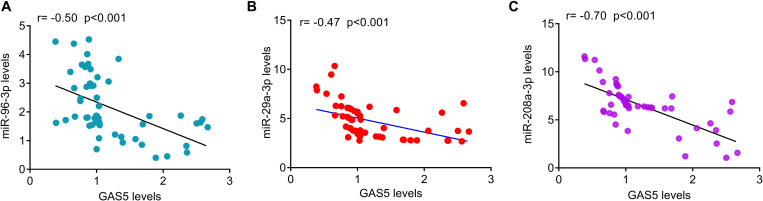
The correlation of serum GAS5 levels with serum miRNAs levels in patients with T2DM. (A) Serum GAS5 levels were negatively correlated with miR-96-3p levels in patients with type-2 diabetes (r = –0.50, p < 0.001). (B) Serum GAS5 levels were negatively correlated with miR-29a-3p levels in patients with type-2 diabetes (r = –0.47, p < 0.001). (C) Serum GAS5 levels were negatively correlated with miR-208a-3p levels in patients with type-2 diabetes (r = –0.70, p < 0.001). r: Spearman correlation coefficient.